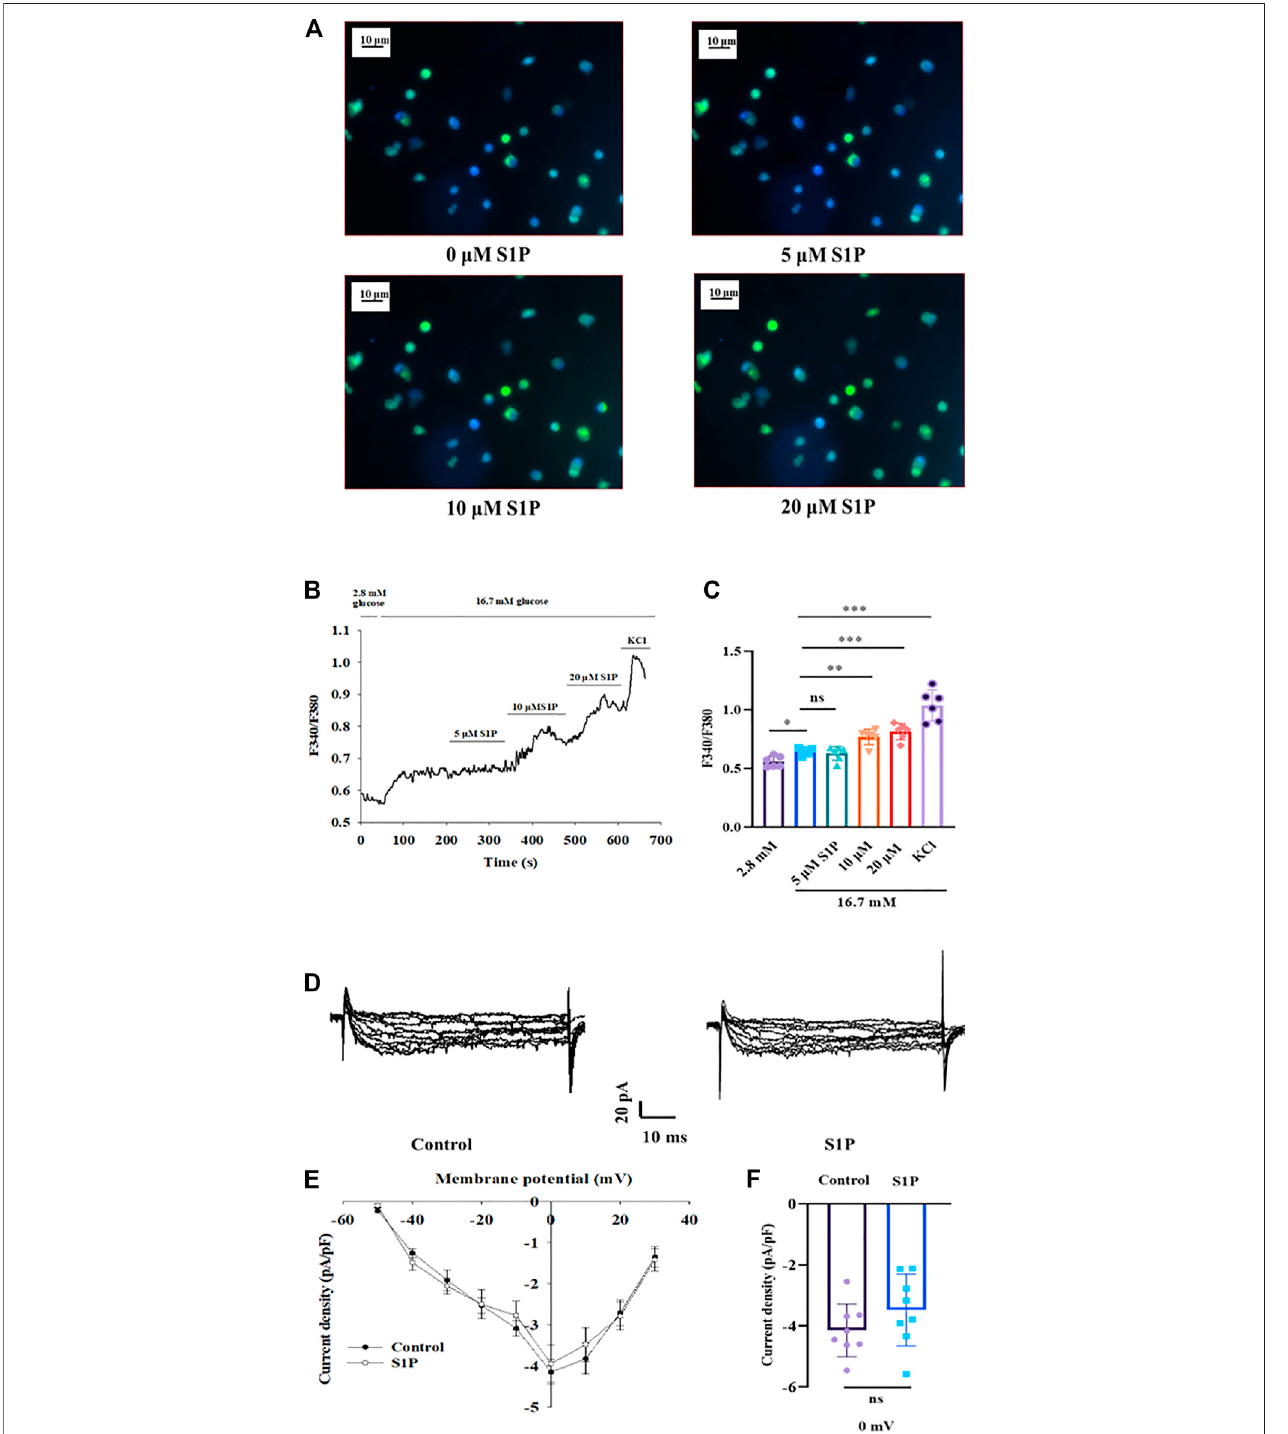
FIGURE3| Effectsofsphingosine1-phosphate(S1P)on[Ca 2+ ] i andvoltage-dependentCa 2+ channel(VDCC)activationinpancreatic β cells. (A) Photomicrograph showing changes in fl uorescence of β cells after treatment with different S1P doses. Blue represents β cells stained with Fura-2 AM. Green represents the increase in fl uorescencedensity ofFura-2AMstaining. (B) ChangesinF340/F380aftertreatment withdifferentdosesofS1Pin16.7 mMglucose,whichre fl ectschangesin[Ca 2+ ] (C) Summary of the mean F340/F380 values after treatment with different doses of S1P ( n (cid:2) 6). * p < 0.05, ** p < 0.01, *** p < 0.001; ns, not signi fi cant; by one-way ANOVA. (D) RepresentativecurrenttracesofVDCCrecordedinthepresenceorabsenceofS1P(10 μ M). (E) Current-voltagerelationshipcurvesofVDCCs in β cells. (F) Summary of the mean current densities recorded at 0 mV depolarization ( n (cid:2) 8). Statistical differences between two groups (with or without S1P) were compared using an unpaired two-tailed Student ’ s t test. The results represent by the mean ± SEM.